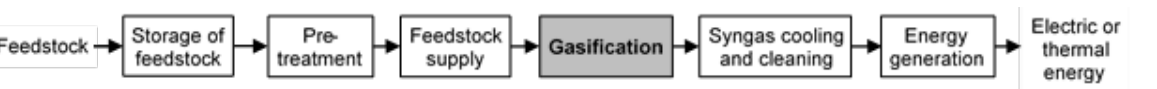
Figure 1. Main stages of a gasification plant (adapted from European Commission, n.d., p. 12).